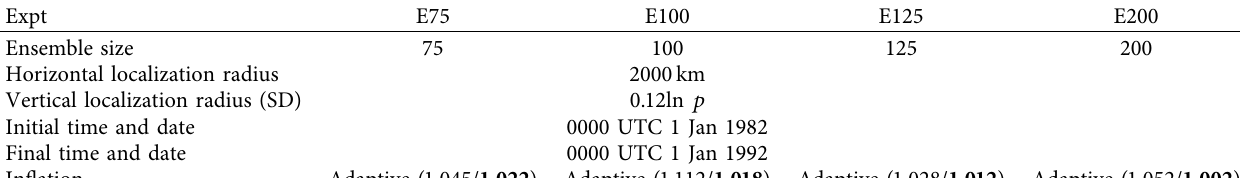
Table 2: Experiment settings using the SPEEDY model to verify the sensitivity of the ensemble size for the CL and CL-MC filters. Expt E75 E100